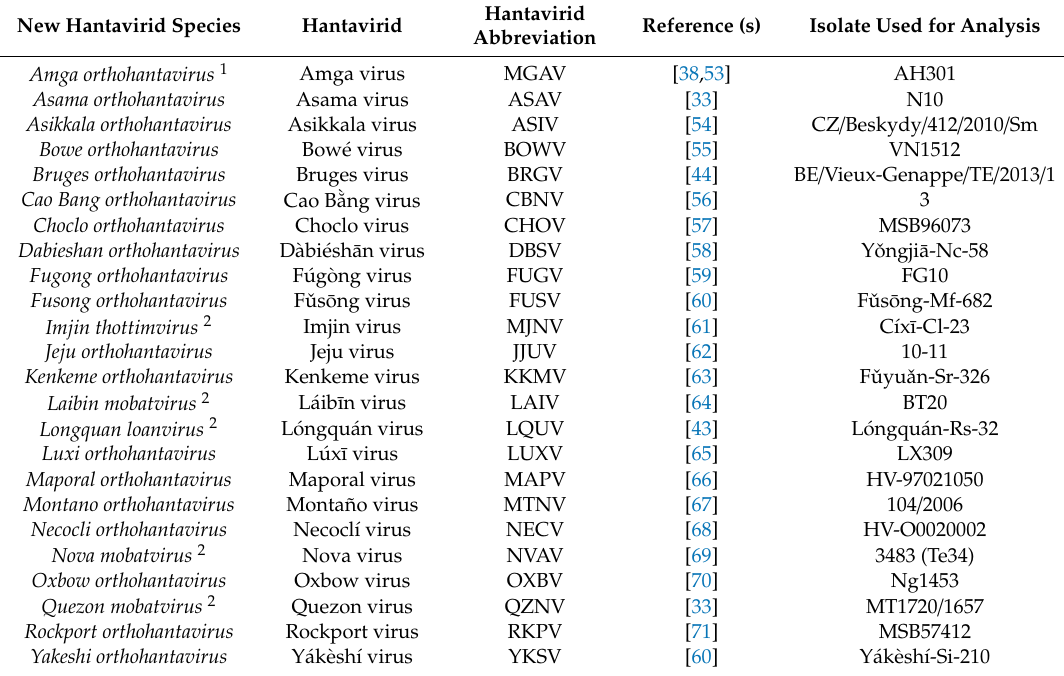
Table 1. New hantavirid species according to the 2017 ICTV taxonomy [52].